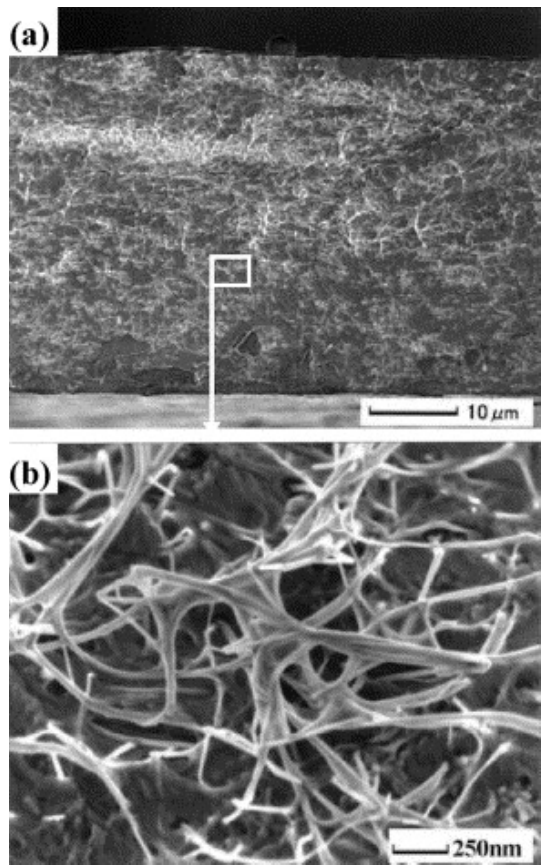
Figure 16. SEM pattern of the cross-section of PI-MWNT (MWNT = 1.14 vol%) composite film ( a ), and the enlargement of its selected area ( b ) [48].